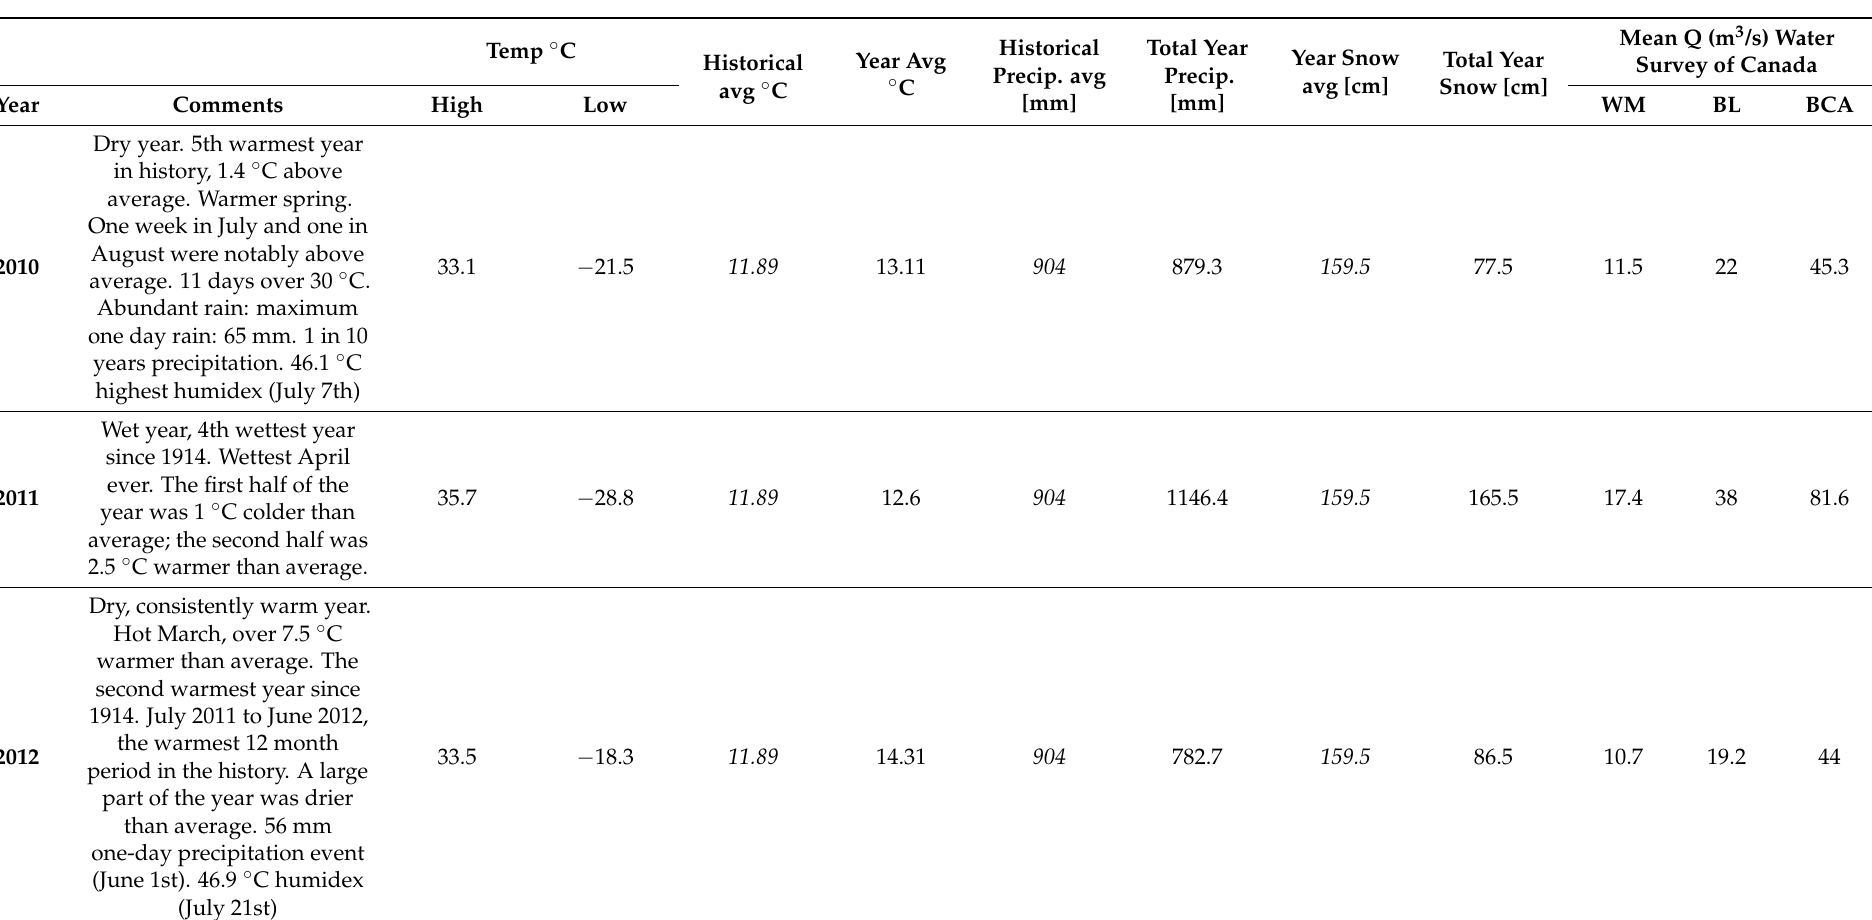
Table A1. Relevant meteorological information from 2010 to 2013. Data obtained from the University of Waterloo weather station (43.4738 N, 80.5576 W). Discharge (m 3 /s) from Water Survey of Canada, stations West Montrose (WM-02GA034), Doon (BL-02GA048) and Brantford (BCA-02GB001). Long-term average discharge WM = 16 m 3 /s (45 y), BL = 31 m 3 /s (8 y) and BCA = 59 m 3 /s (65